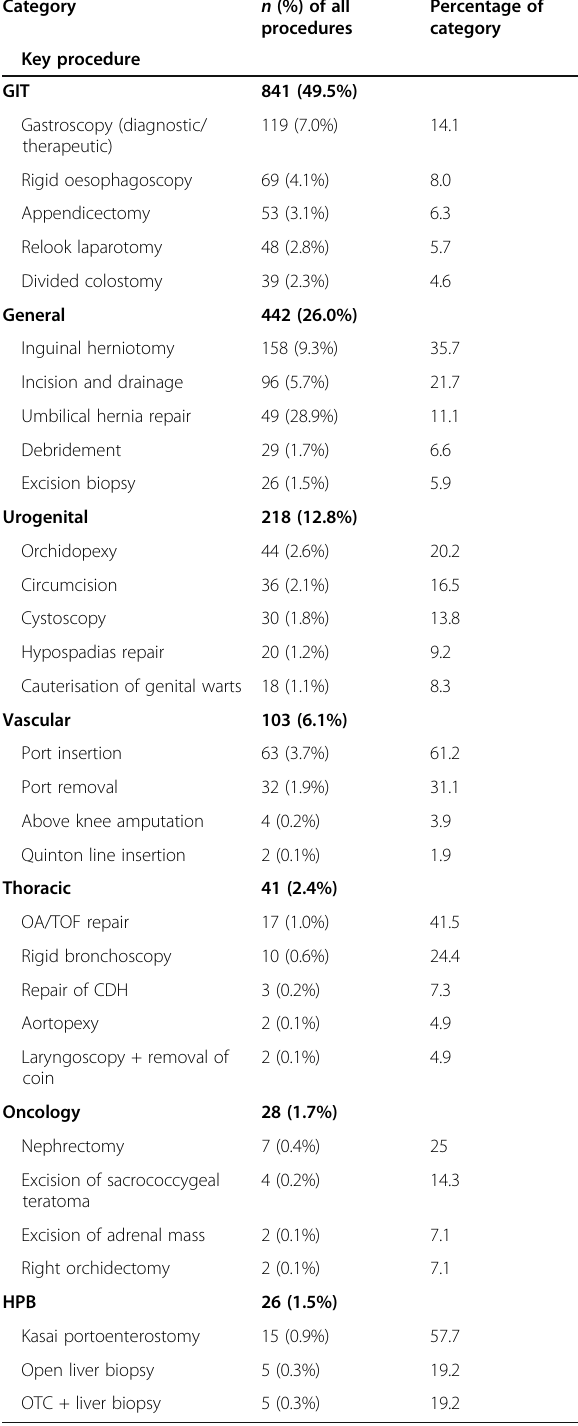
Table 3 Most common paediatric surgical procedures per subspecialty